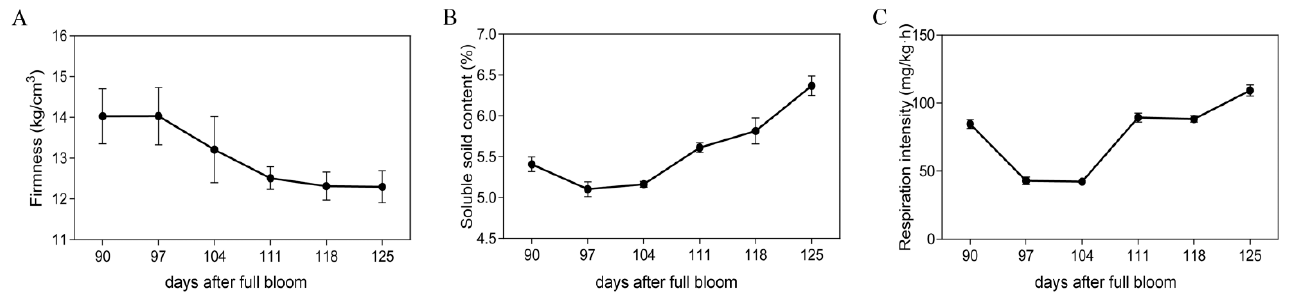
Figure 1. Physiological indexes investigation. ( A ) Firmness values of fresh fruit flesh at six preharvest stages. ( B ) Soluble solid contents of fresh fruit flesh at six preharvest stages. ( C ) Respiration intensities of fresh fruit flesh at six preharvest stages. At least three readings were used to plot one point. The data represent the error bars ± SE (Standard Error) of three biological replicates.